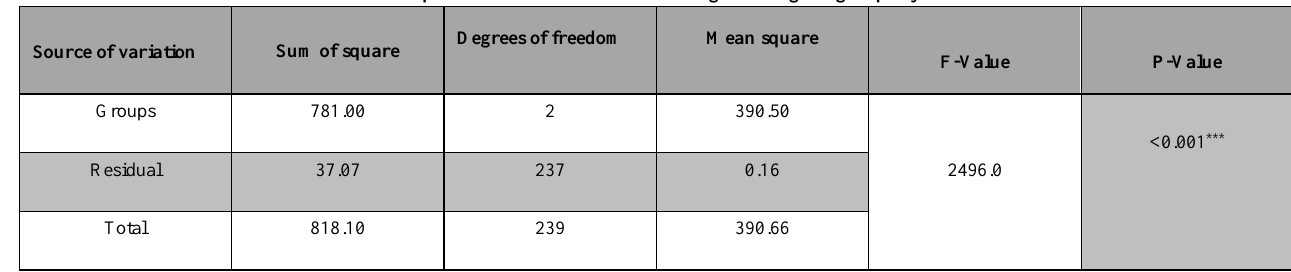
Table 3. Comparison of mean shear bond strength among the groups by ANOVA.